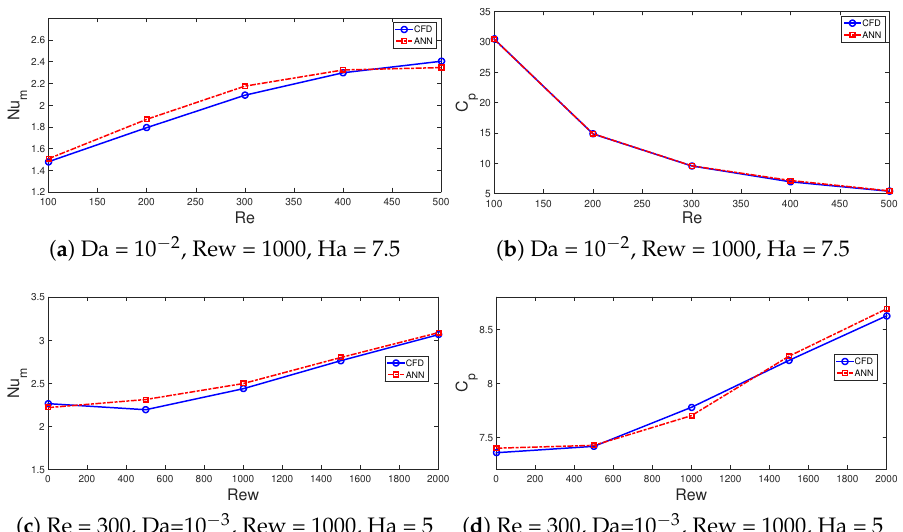
Figure 17. Comparison of average Nu ( a , c ) and pressure coefficients ( b , d ) variations obtained with CFD and NN.